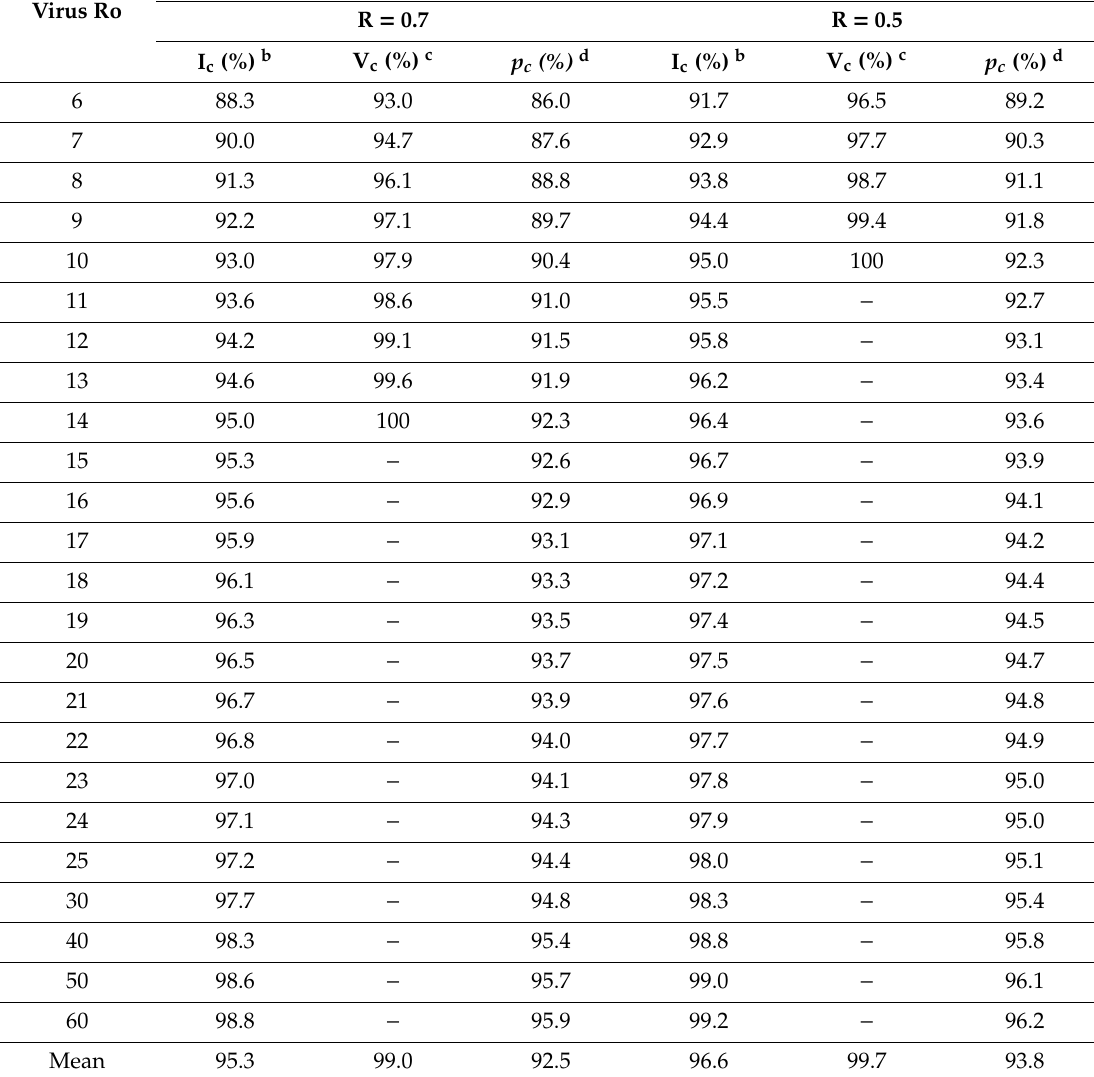
Table 3. The critical prevalence of protected individuals (I c ), critical vaccination coverage (V c ), and critical prevalence of positive anti-measles serologic results (p c ) associated with an e ff ective basic reproductive number, R, of 0.7 and 0.5, for measles viruses with basic reproductive numbers (Ro) ranging from 6 to 60. Herd Immunity Thresholds I c , V c , and p c Associated with an E ff ective Basic Reproductive Number, R a , of 0.7 and 0.5 Measles Virus Ro R = 0.7 R = 0.5